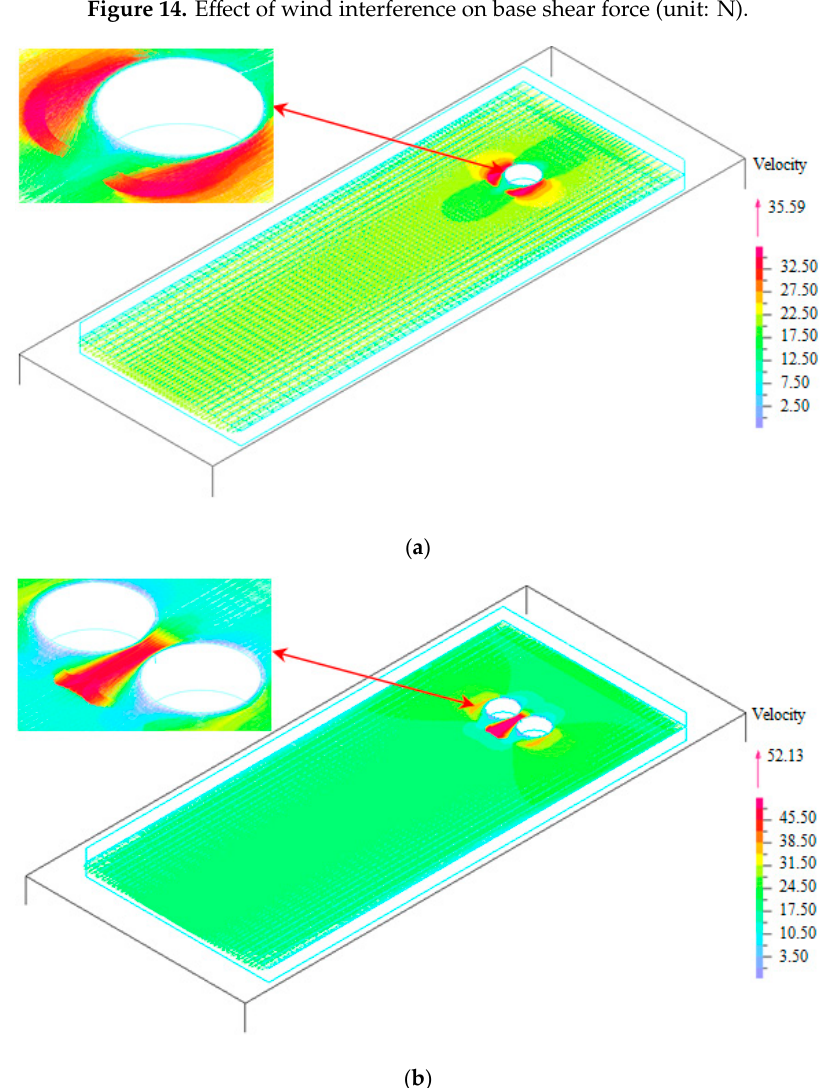
Figure 15. E ff ect of wind interference on wind velocity field (unit: m / s). ( a ) Single tank. ( b ) Double tank.